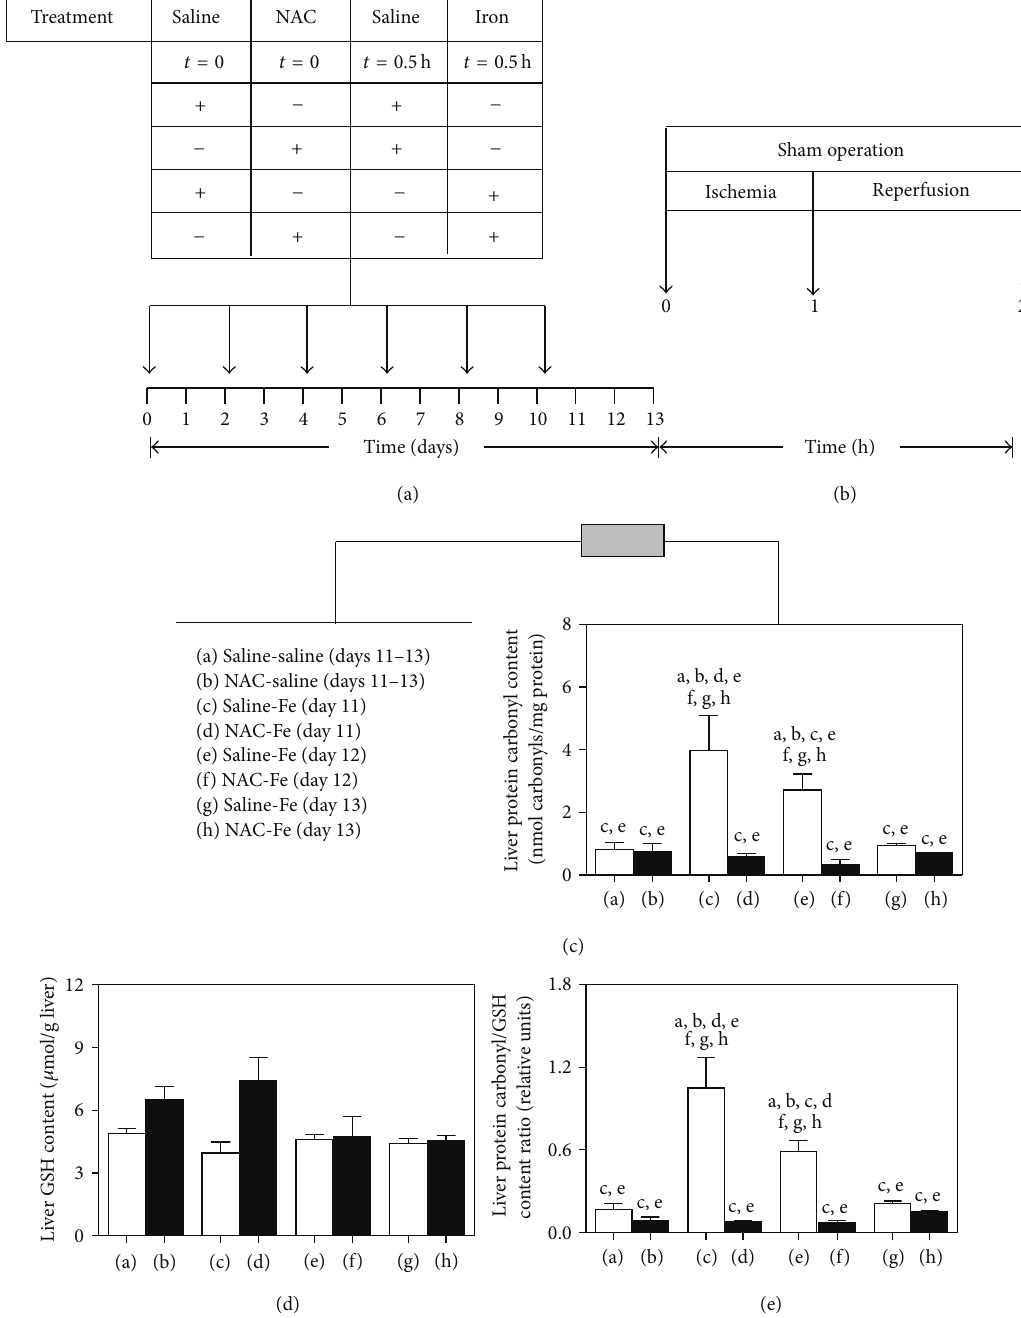
Figure1:Experimentalshort-termprocedureforN-acetylcysteine(NAC)and/oriron(Fe)administrationintherat(a),ischemia-reperfusion (IR) protocol (b), liver protein carbonyl content (c), liver reduced glutathione (GSH) content (d), and protein carbonyl/GSH content ratios (e). Animals were given either saline or NAC (1g/kg) or saline followed by Fe (50mg/kg) or saline, 0.5 h after NAC, at time 0 (controls), 2, 4, 6, 8, and 10 days. Liver oxidative stress-related parameters (protein carbonyl and GSH levels expressed as protein carbonyl/GSH content ratios) were determined at days 11, 12, and 13. At day 13, groups of animals were subjected to sham operation or 1h ischemia followed by 20 h reperfusion. Blood and liver samples were obtained at the end of the reperfusion period (21h) for assessment of serum transaminases, liver histology, and hepatic GSH content and p65 NF- 𝜅 B DNA binding. In (c), (d), and (e), data are expressed as means ± SEM for 3 to 11 animals per group. Significance studies (one-way ANOVA and Newman-Keuls’ test; 𝑃 < 0.05 ) are indicated by the letters identifying each experimental